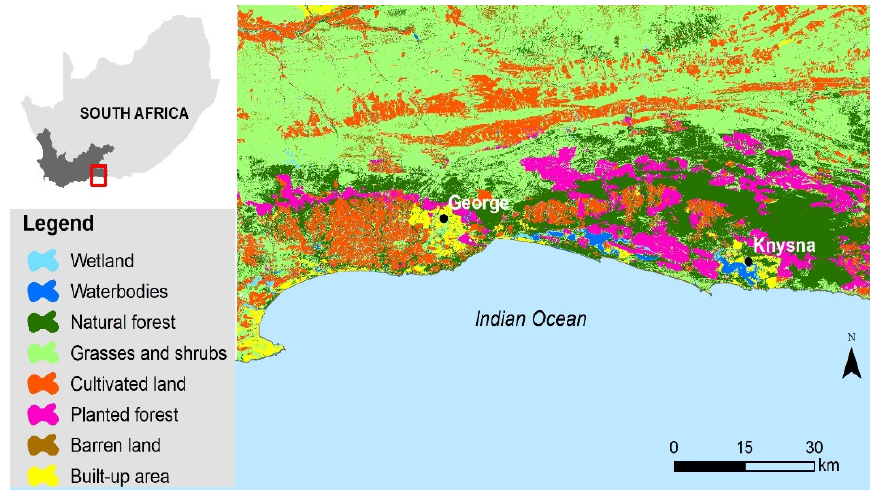
Figure 1. Location of the study area in the Western Cape province, South Africa.